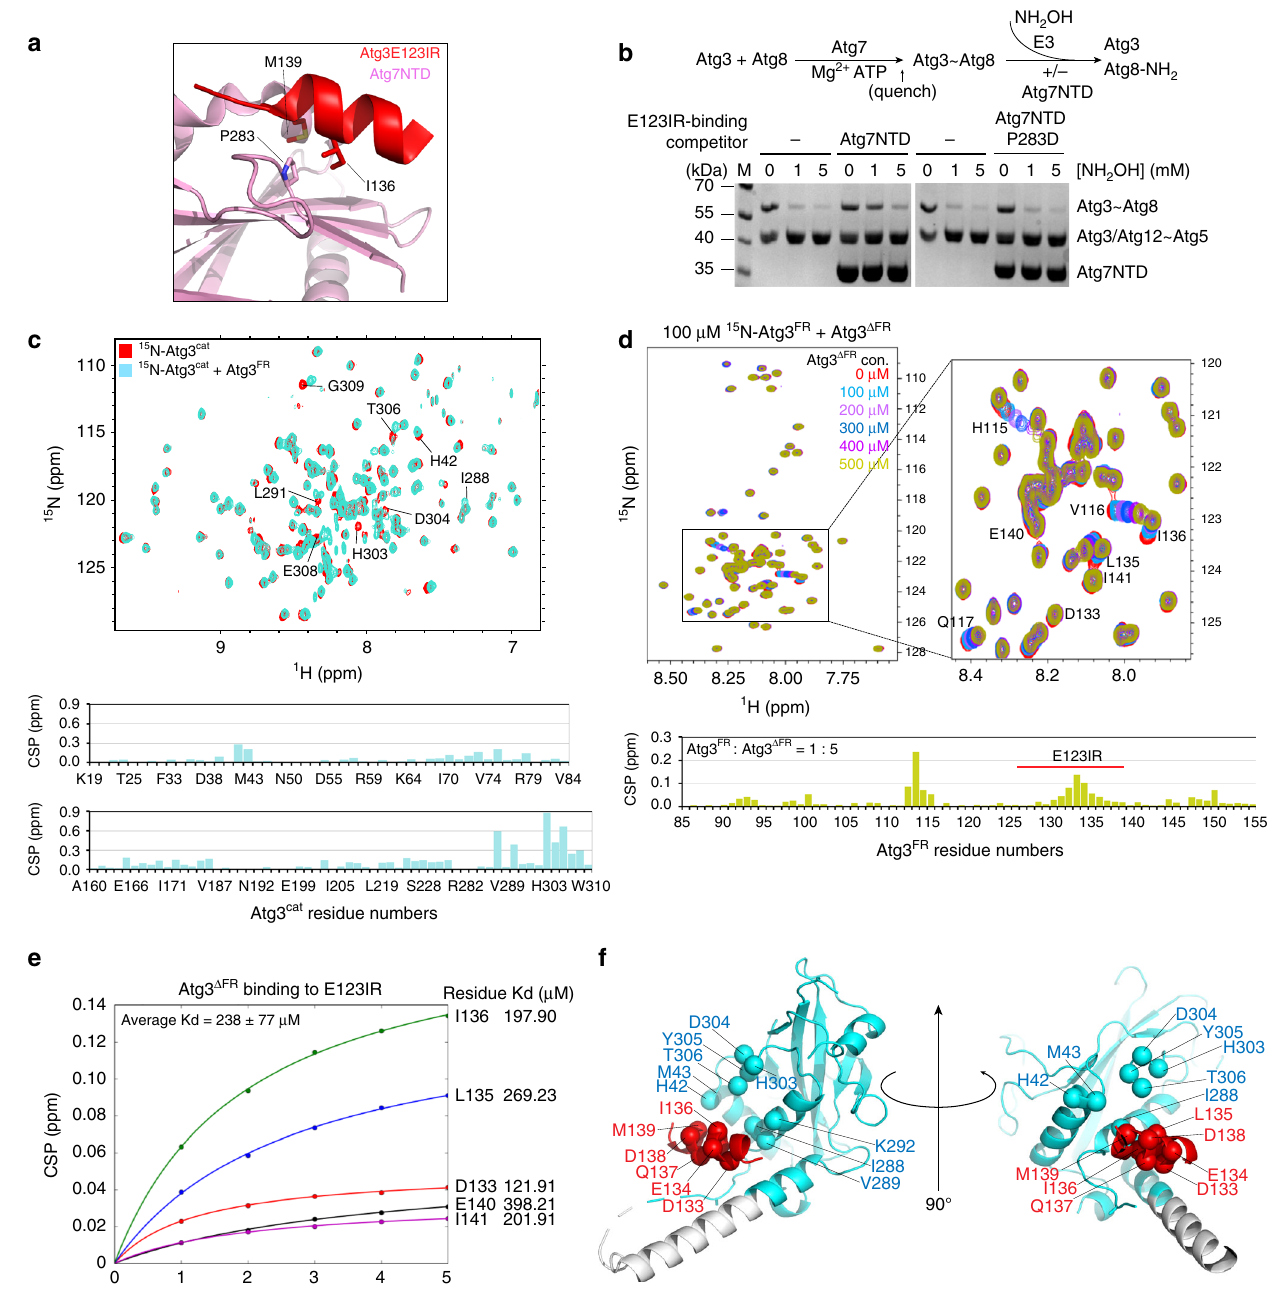
Fig. 4 E123IR binds the E1 Atg7 and E2 core domain Atg3 cat . a Close-up showing interactions between Atg3 E123IR and N-terminal domain (NTD) of Atg7 (PDB 3T7G). b Effects of Atg3 E123IR -binding WT Atg7 NTD and non-binding mutant (P283D) on E3-stimulated intrinsic reactivity of Atg3~Atg8 intermediate, as monitored by pulse-chase discharge to NH 2 OH. c [ 15 N, 1 H] TROSY spectra of 15 N-labeled Atg3 cat alone (red) or in 1:44 mixture with unlabeled Atg3 FR (cyan), with chemical shift perturbations (CSPs) plotted per residue below. d [ 15 N, 1 H] TROSY spectra of 15 N-labeled Atg3 FR titrated with unlabeled Atg3 Δ FR , with representative (1:5 molar ratio Atg3 FR vs. Atg3 Δ FR ) CSPs plotted per residue below. e Estimated binding af fi nities between E123IR residues and Atg3 Δ FR , based on CSPs observed upon titrating increasing concentrations of Atg3 Δ FR . f Residues corresponding to greatest CSPs are shown as spheres on the structure of Atg3 (PDB 2DYT), except E308 and G309 that are not visible in the structure shift perturbations in [ 15 N, 1 H] TROSY spectra of 15 N-labeled Atg3 FR (Fig. 6a) as for Atg3 alone (Fig. 4d). NATURE COMMUNICATIONS| (2019) 10:3600